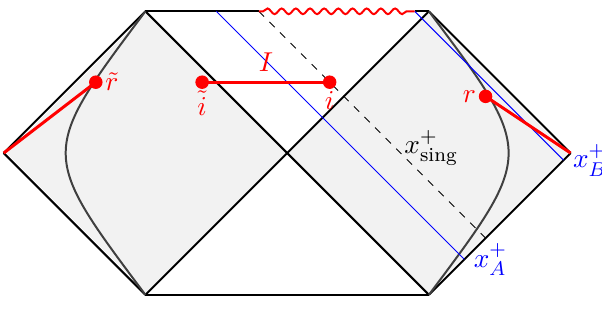
Figure 8 . During the pulse ( x + decreasing entropy is always bigger than or equal to the location x +